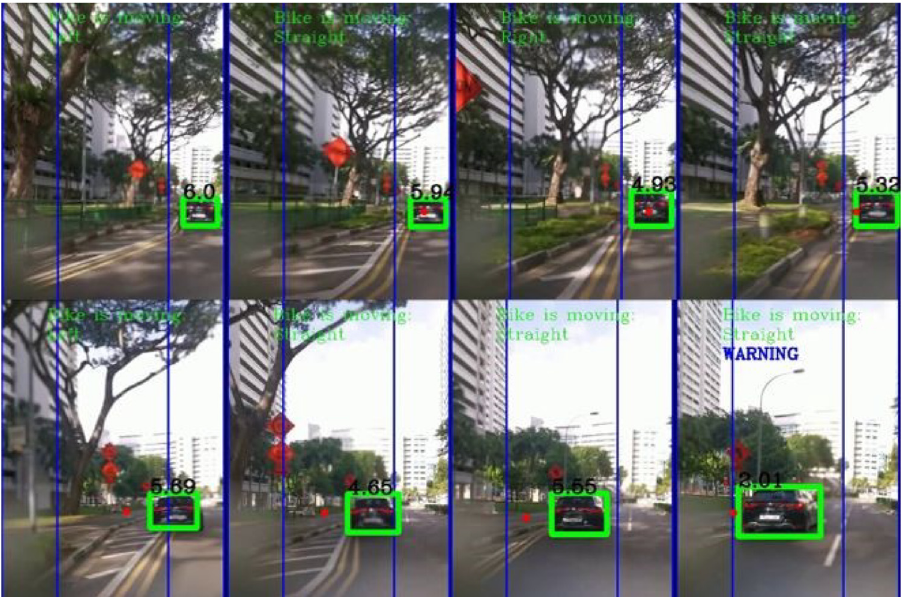
Figure 10 Screenshot of the Advanced Forward Collision Warning